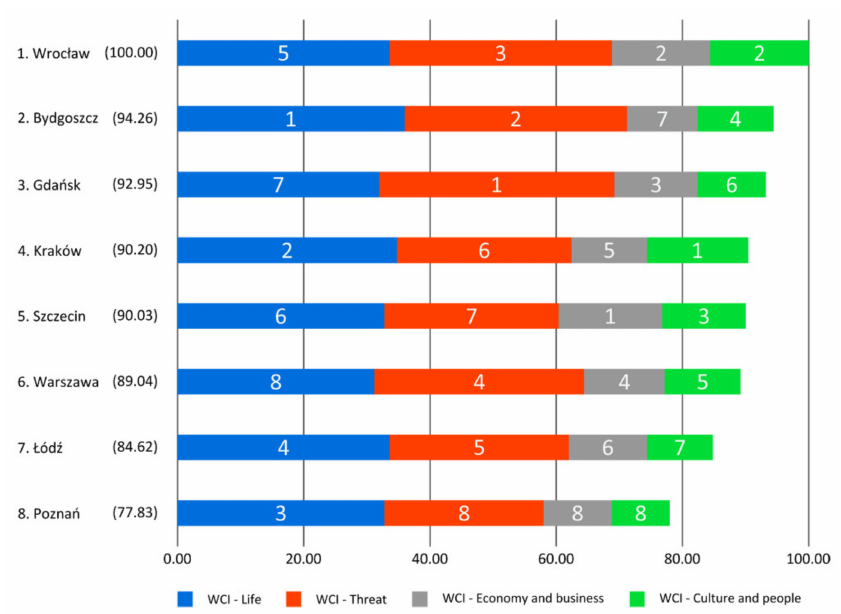
Figure 1. Ranking of the effectiveness of the use of water resources in Polish cities. Source: oees.pl/ water-city-index-2020/ (accessed on 23 May